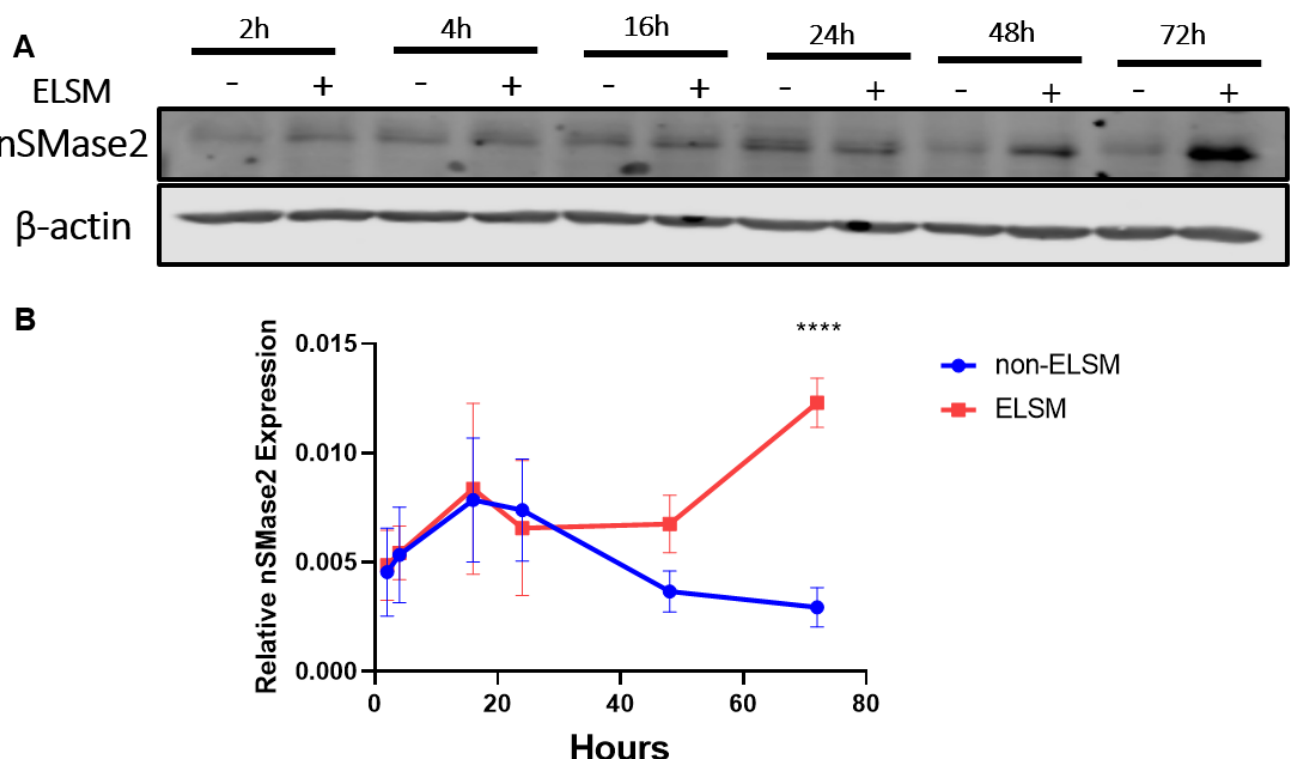
Figure 3. nSMase2 protein levels were determined by Western blot after treatment with or without ELSM for the indicated times. ( A , B ) Western blot analysis of nSMase2 expression levels in C-MSC; β -actin protein levels were used as loading control (**** p < 0.0001, n = 3).